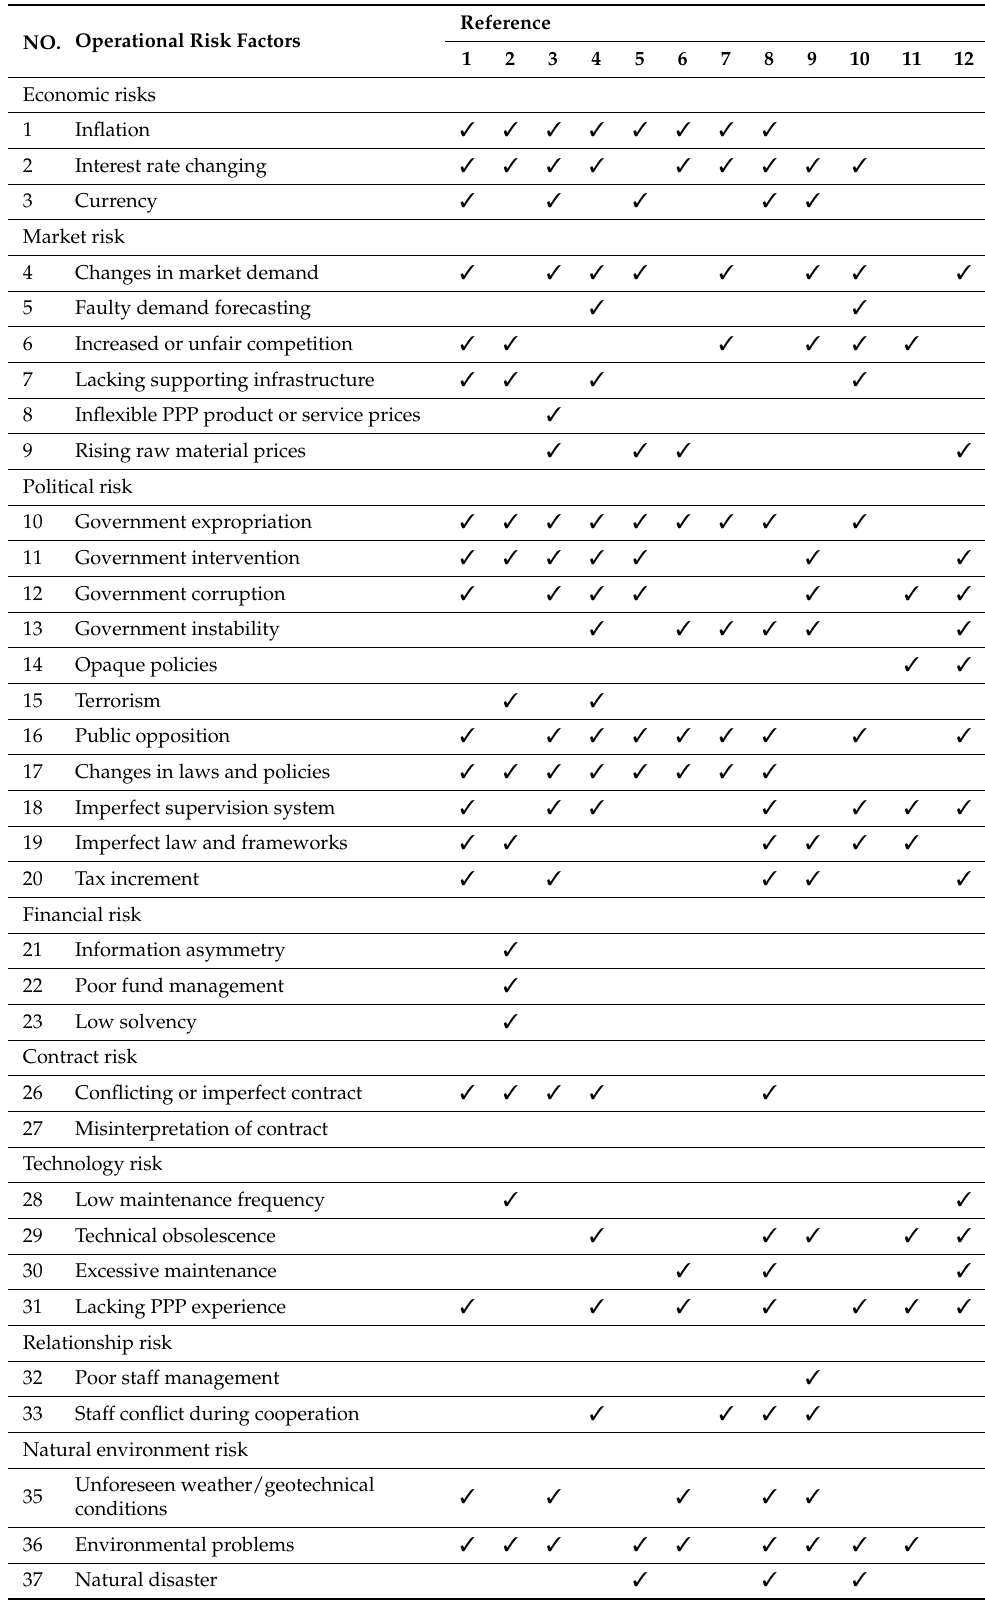
Table 2. Identified operational risk factors for PPP infrastructure